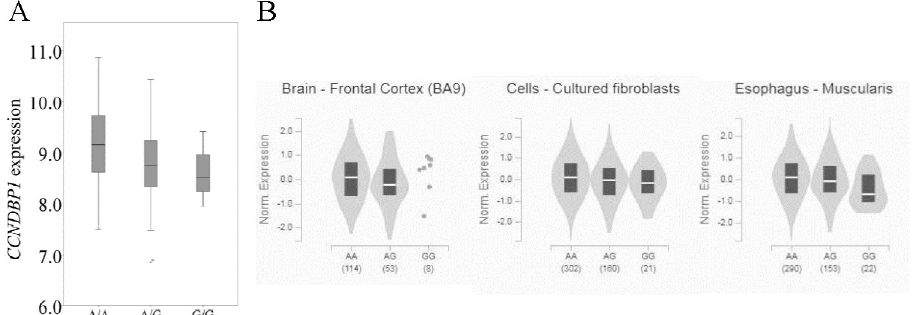
Fig 5. Relationship between rs12909095 genotype and CCNDBP1 expression in LCL at CEU population from literature [12] (A) and GTEx database (B). The x -axis indicates genotype, while y -axis shows gene expression. For part A, the expression is displayed by FPKM and log transformed. For part B, the sample size for each group is shown in bracket.